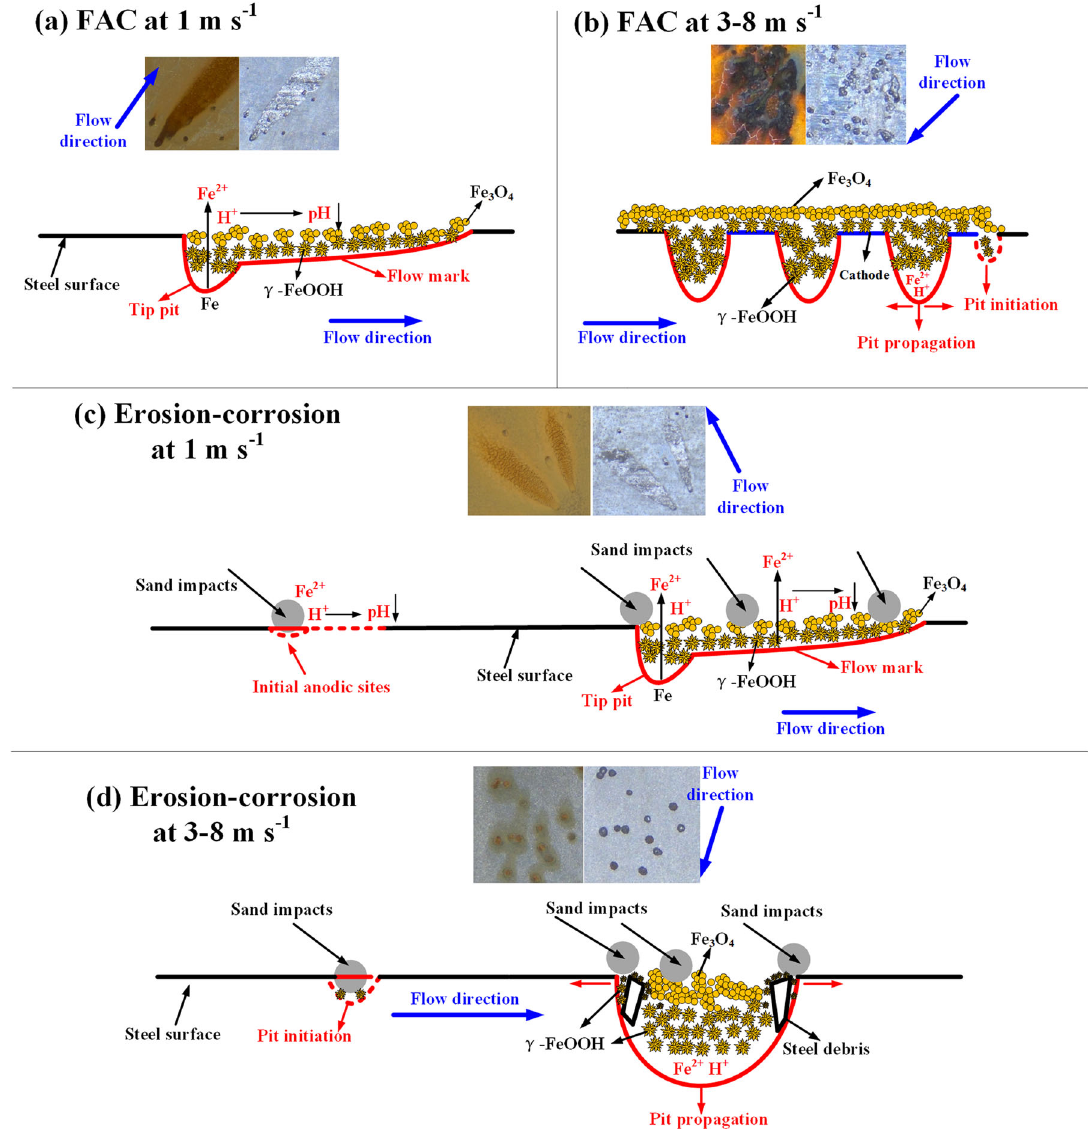
Fig. 10 Schematic diagrams of the propagation of FAC and erosion − corrosion in natural seawater at different fl ow velocities. a , b The propagation of FAC at 1 m s − 1 and 3 − 8 m s − 1 . c , d The propagation of erosion − corrosion at 1 m s − 1 and 3 − 8 m s − 1